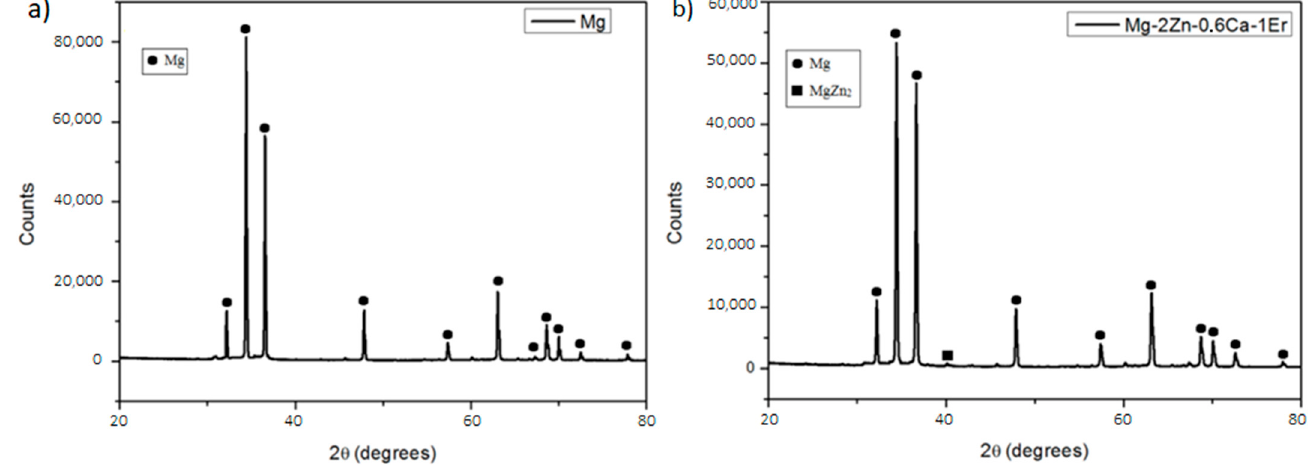
Figure 1. ( b ) X-ray diffraction results of extruded Mg-2Zn-0.6Ca-1Er in the longitudinal direction. ( a ) The XRD plot for pure Mg is presented for reference.